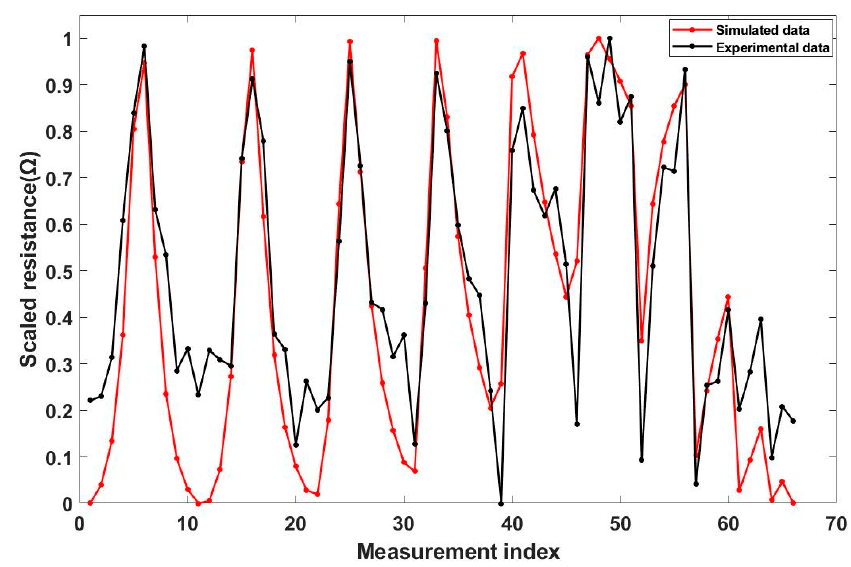
Figure 10. Simulated and experimental resistance plot for case 1.